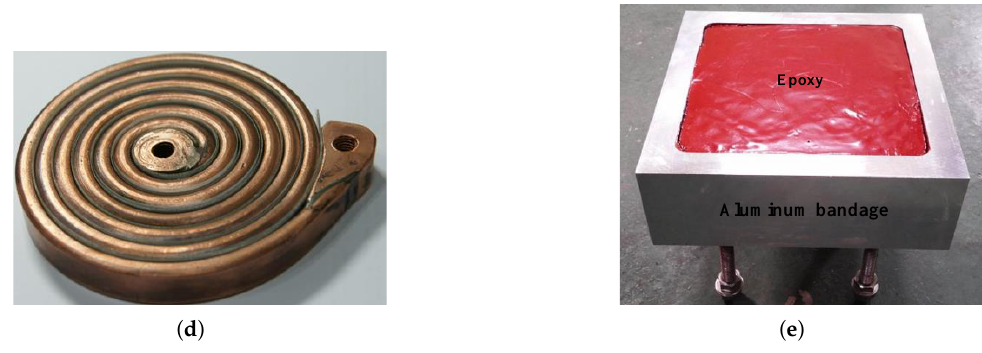
Figure 5. Experimental set up for EMF free bulge test. ( a ) Forming coil with a test bed. ( b ) Forming